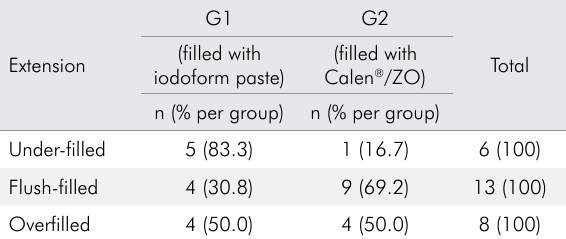
Table 3. Level of the root filling material for each